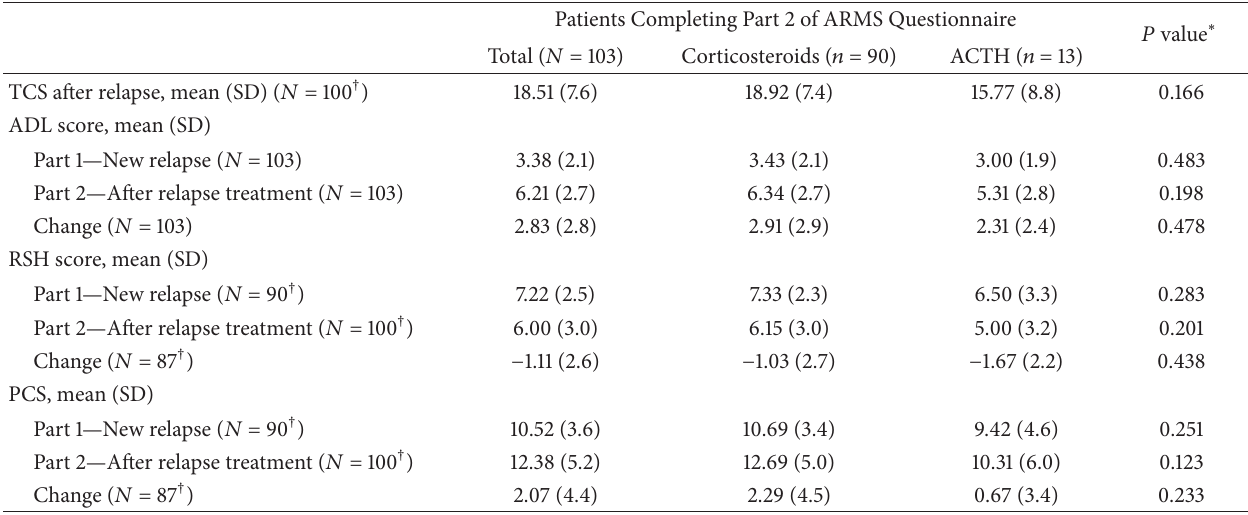
Table 5: Total Composite Score, Activities of Daily Living Score, and Return to Previous State of Health Score. Patients Completing Part 2 of ARMS Questionnaire